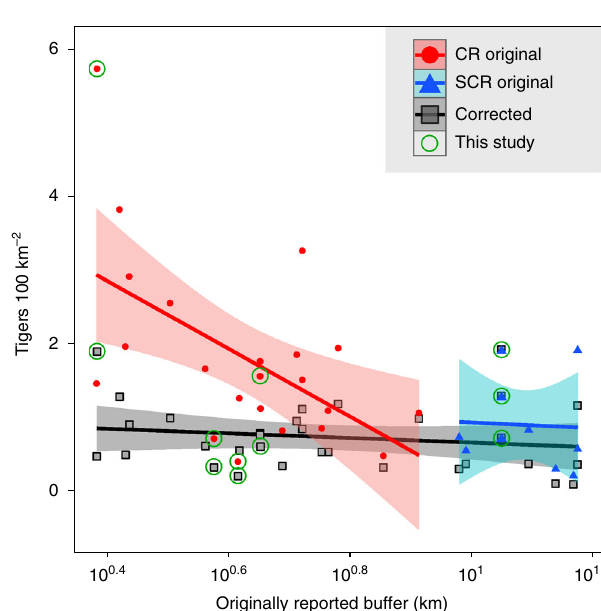
Fig. 2 Tiger density bias due to the use of camera trap grid buffers. Tiger densities reported for Indonesian and Malaysian rainforests as a function of the originally reported buffer width used to calculate the effective area sampled ( n = 29 estimates from 13 forests). Data point shapes denoted by the analysis method used to estimate density (circles for CR, triangles for SCR, squares for corrected densities, the latter recalculated using a standard buffer length of 9.0 km derived from the new SCR analyses in this study). Red indicates CR studies, blue for SCR studies, and gray